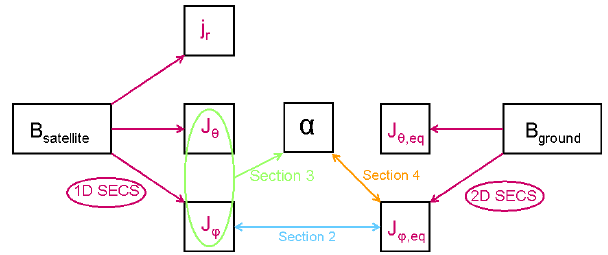
Fig. 1. The structure of the paper and the applied techniques. Section 2: Under the 1D condition, J φ determined from magnetic data from the CHAMP satellite using the 1D SECS method is shown to be equal to J φ,eq , the φ component of the equivalent current density determined from IMAGE magnetometer data using the 2D SECS method ( J eq,θ is the θ component of the equivalent current density). Section 3: Under the 1D condition, α is shown to equal − J φ /J θ . Section 4: Magnetic vector data from the CHAMP satellite during 2001–2002 is used to make statistical maps of the ionospheric and field-aligned current density components, and to establish a relationship between J φ and α . This makes it possible to estimate α from ground magnetic data. In a 1D case, J θ = J cf and J φ = J df . j r is the field-aligned component. In a 2-D case, J df = J θ,eq ˆ e θ + J φ,eq ˆ e φ